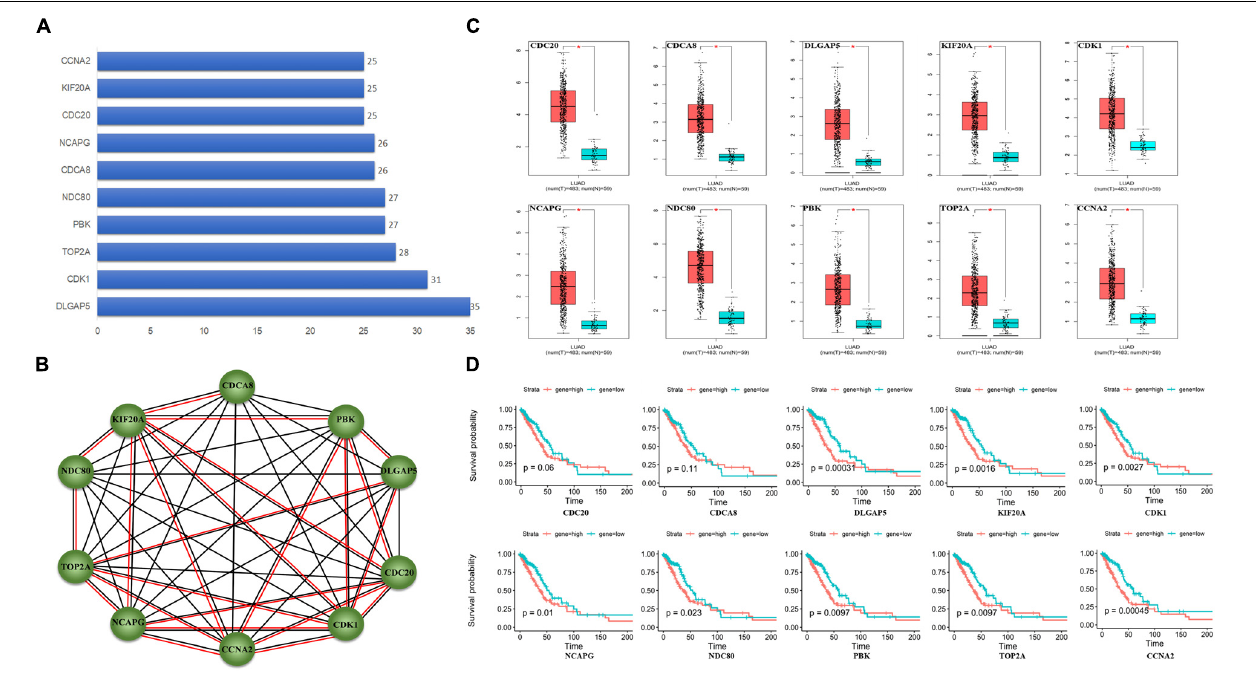
FIGURE 3 | Protein–protein interaction (PPI) network analysis. (A) Ten hub genes in PPI based on the DEmRNAs with a combined score of > 0.9 and degree ≥ 25. (B) Ten hub genes interaction network. Circles indicate the genes in the PPI network, and the connection indicates the potential interaction between different mRNAs. The red line means physical interaction, and the black line means co-expression with each other. (C) Gene expression of 10 hub genes between LUAD tumor and normal tissues. (D) Overall survival curves of the 10 hub genes in LUAD. * p <